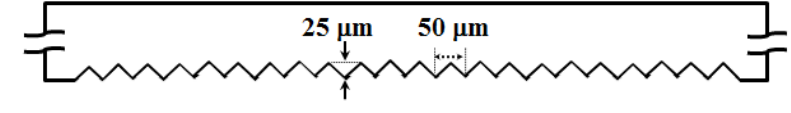
Figure 7. Schematic drawing of the mold with V-cut patterns. The sizes of the V-cut pattern were 25 µm high and 50 µm wide.